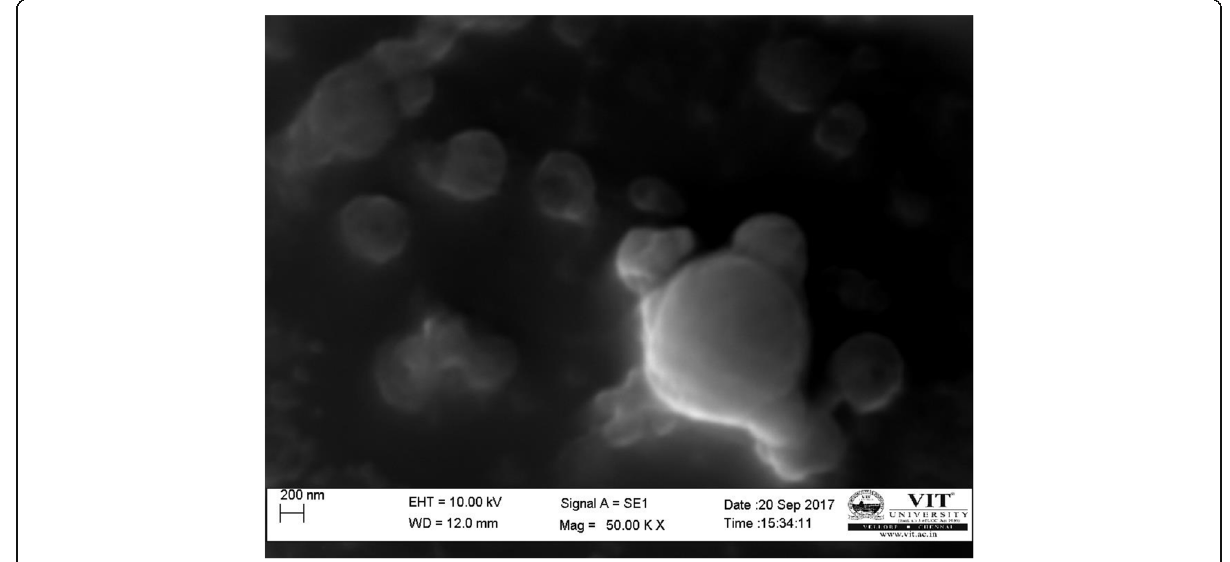
Fig. 3 SEM Analysis of the biosynthesised selenium